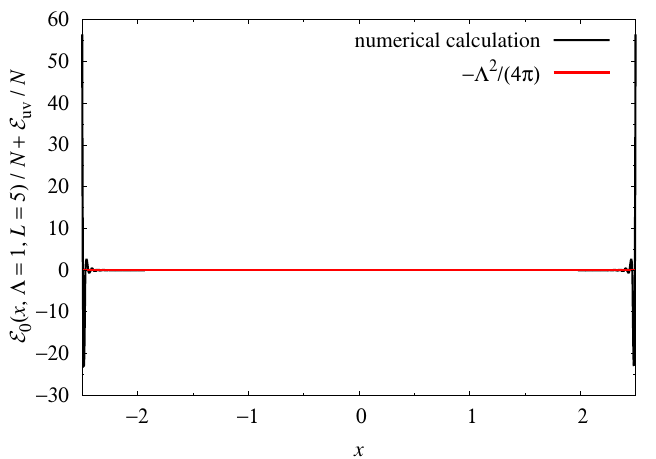
Figure 4 . Veri(cid:12)cation of the constancy of ( E 0 + E uv ) with respect to x . (cid:3) = 1, L = 5 in this